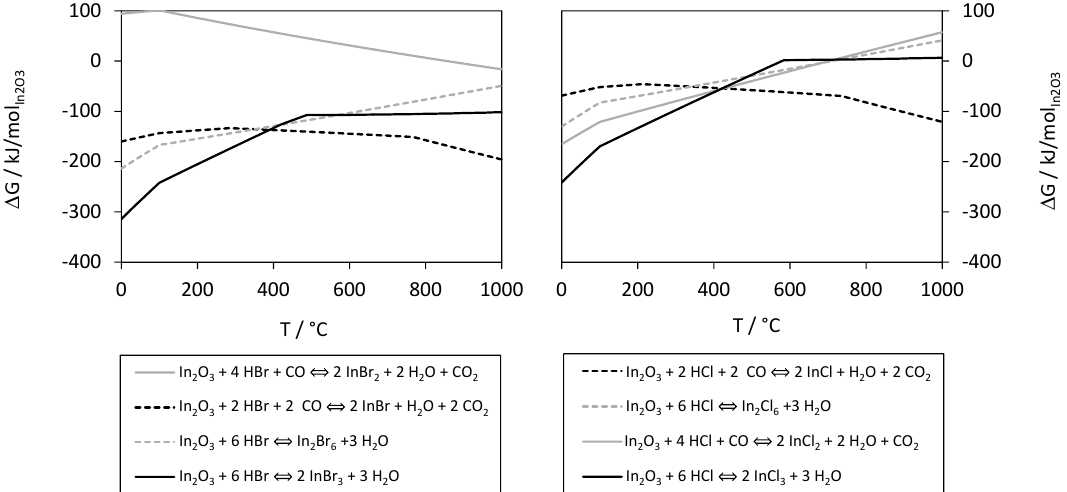
Figure 6. Gibbs free energy for hydrobromination ( left ) and hydrochlorination ( right ) of indium oxide.